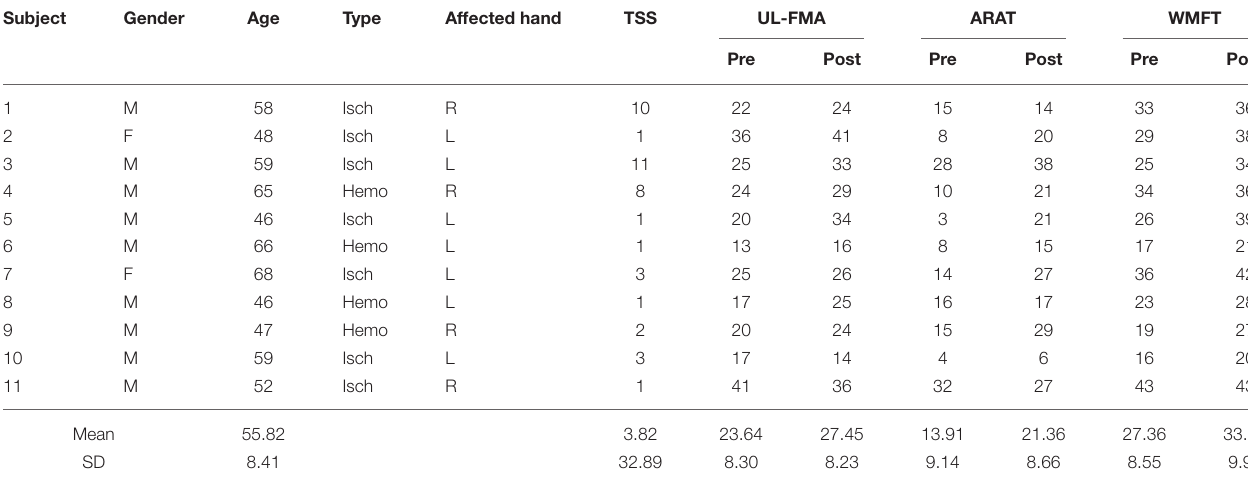
TABLE 1 | Basic information of 11 post-stroke